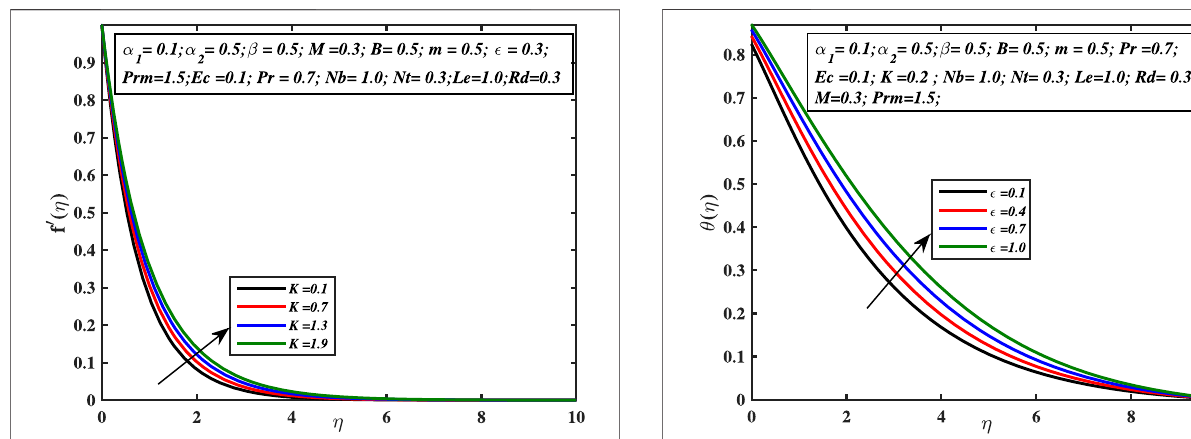
FIGURE 6 | Effect of K on the velocity curve.